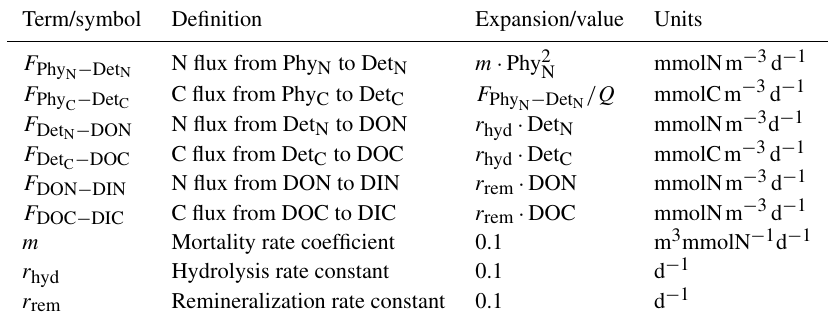
Table 1. Definitions, expansions/values and units of terms/symbols regarding the fluxes between model compartments. Term/symbol Definition Expansion/value Units F Phy − Det N N